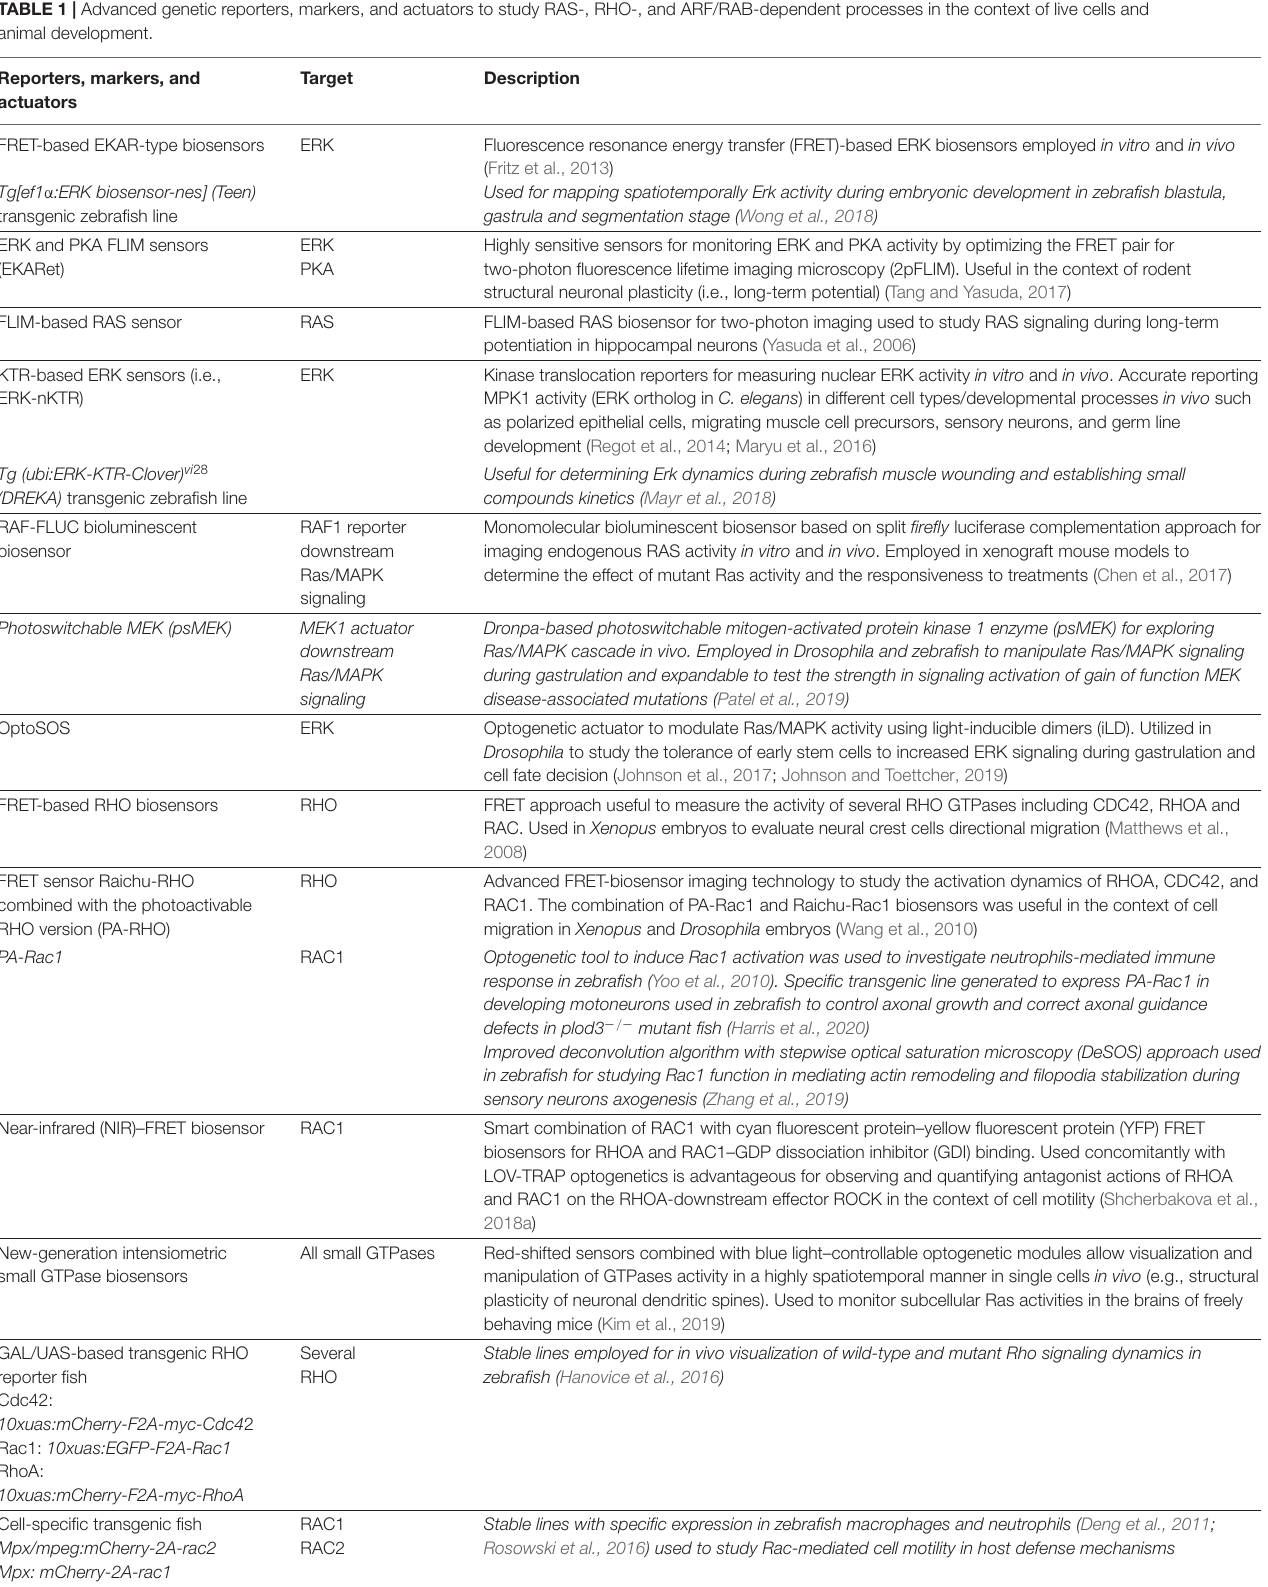
TABLE 1 | Advanced genetic reporters, markers, and actuators to study RAS-, RHO-, and ARF/RAB-dependent processes in the context of live cells and animal development. Reporters, markers, and Target actuators